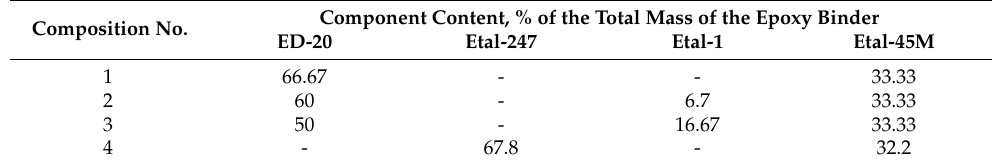
Table 1. The composition of the studied epoxy polymers.